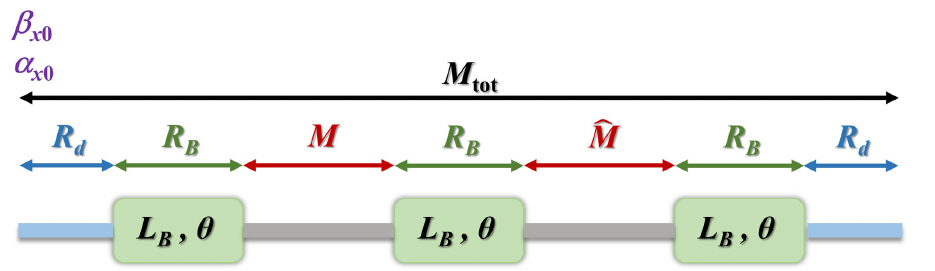
FIG. 1. Schematic of the TBA structure with three identical dipole magnets of length L B and bending angle θ . R d and R B represent the transfer matrix of the drift space and the dipole, respectively. The elements in the section between the adjacent dipoles are assumed as nondipole elements, e.g., quadrupoles, sextupoles and drifts, the transfer matrices of which are expressed as M and matrix is denoted as M and β x 0 , α x 0 are the horizontal Twiss functions at the entrance of the tot